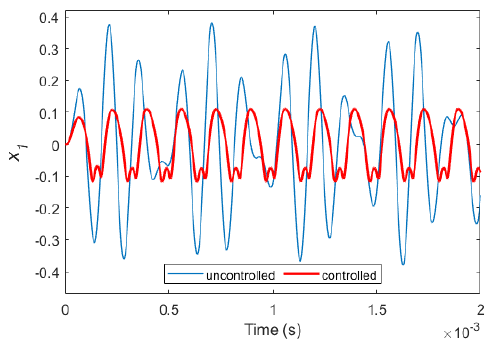
Figure 5. Variation of x 1 versus time for controlled and uncontrolled systems considering p = 19, q = 11, and β = 200.